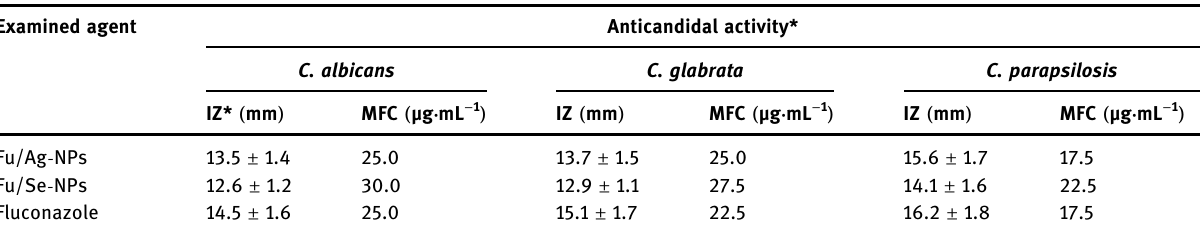
Table 4: Anticandidal potentialities of Fu - synthesized NPs ( Fu/Ag - NPs and Fu/Se - NPs ) against pathogenic Candida sp. Examined agent